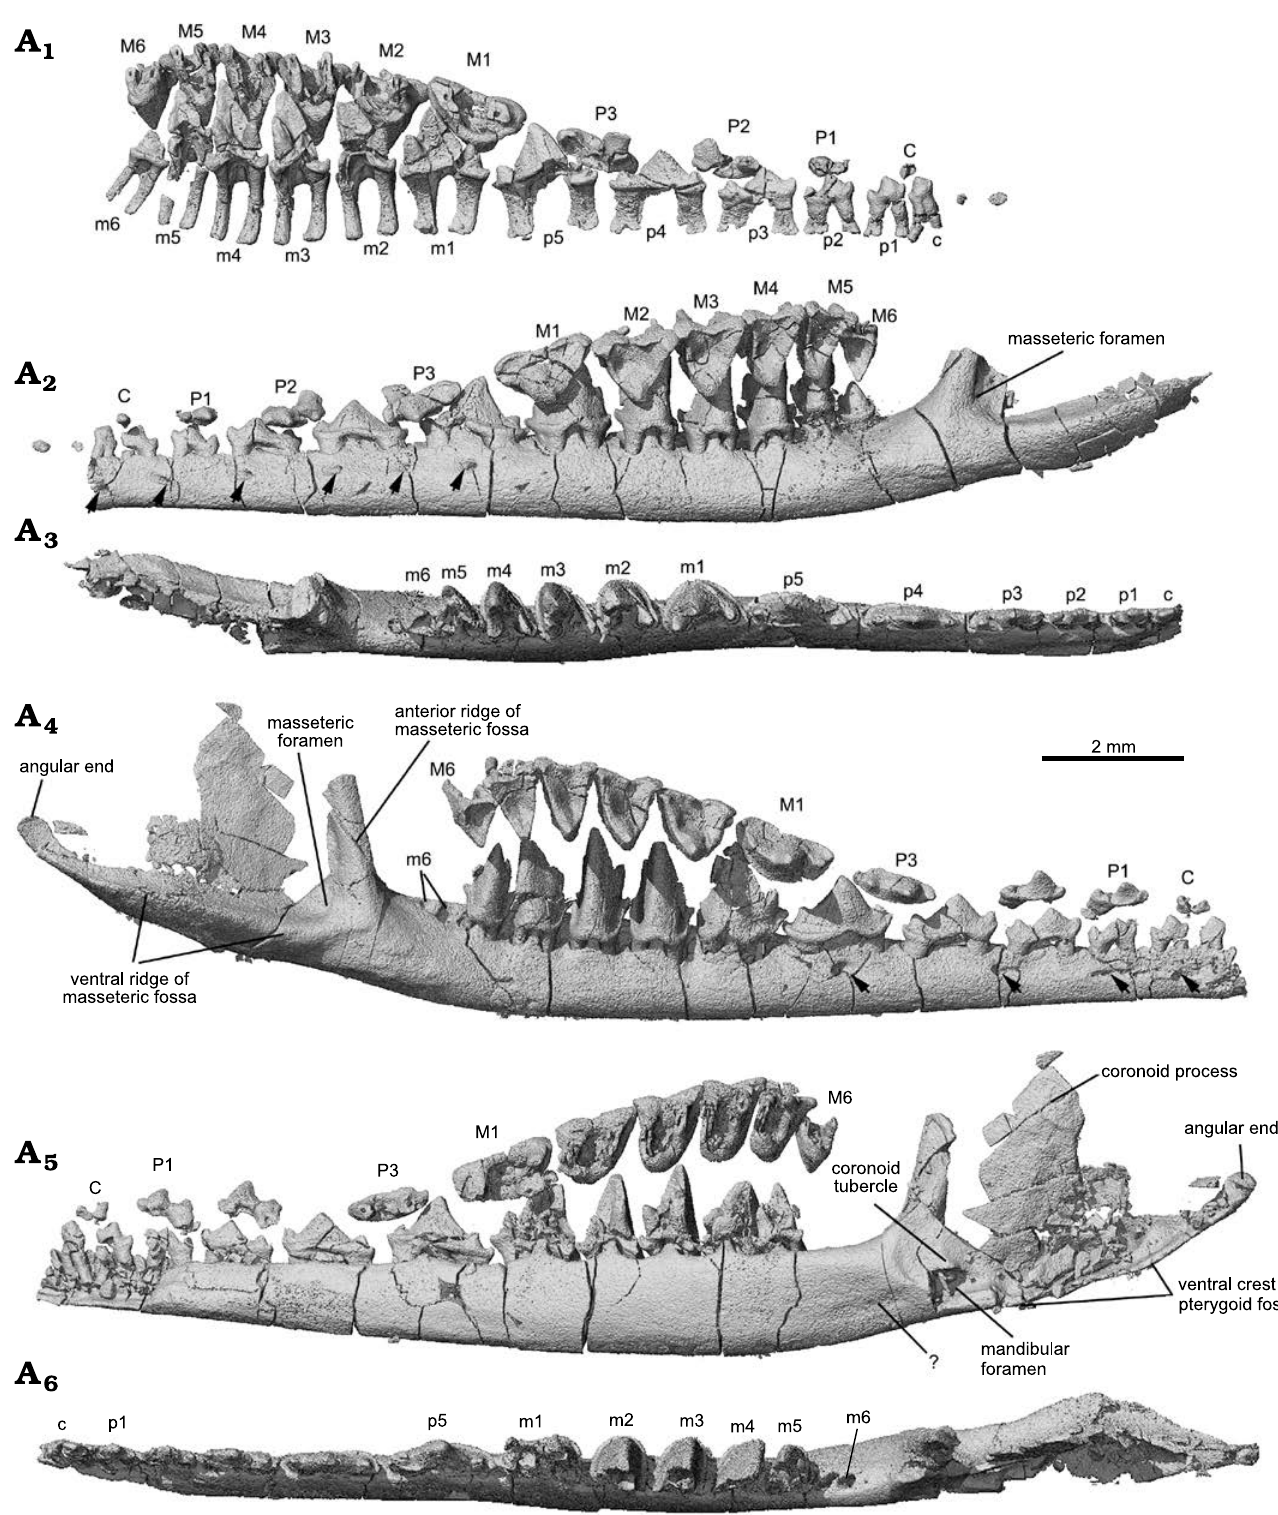
Fig. 3. CT-rendered lower jaws and dentitions of the trechnotherian mammal Lactodens sheni Han and Meng, 2016 (ZGY0053), from Aptian, Lower Cretaceous Jiufotang Formation of Dapingfang, Caoyang City, Liaoning Province, China. A 1 –A 3 , left upper and lower dentition and dentary in medial (only teeth), lateral, and occlusal views, respectively. A 4 –A 6 , right upper and lower dentition and dentary in lateral, medial, and occlusal views, respec- tively. Note: angular end is not the mandibular condyle (see Fig. 6); coronoid tubercle, mis-labelled as “cp” in Han and Meng (2016: fig. 10). Upper and lower teeth in A 1 , A 2 , A 4 , A 5 are in the original position that were preserved. Arrows in A 2 , A 4 point to mental foramina (note the difference between the two mandibles). Question mark in A 5 points to a faint groove that is not the Meckelian groove (compared to that of Origolestes lii in Fig.